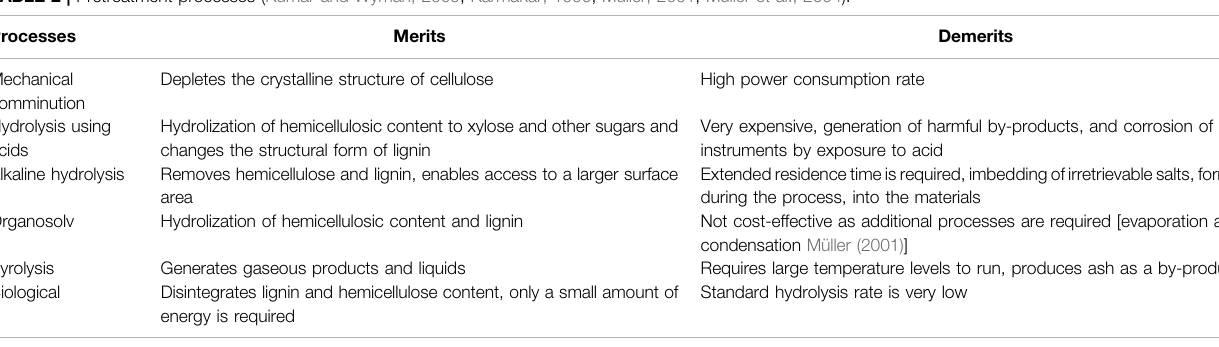
FIGURE 2 | Various mechanical pretreatment techniques (Iswanto et al., 2010; Yang et al., 2011; Onumaegbu et al., 2018).